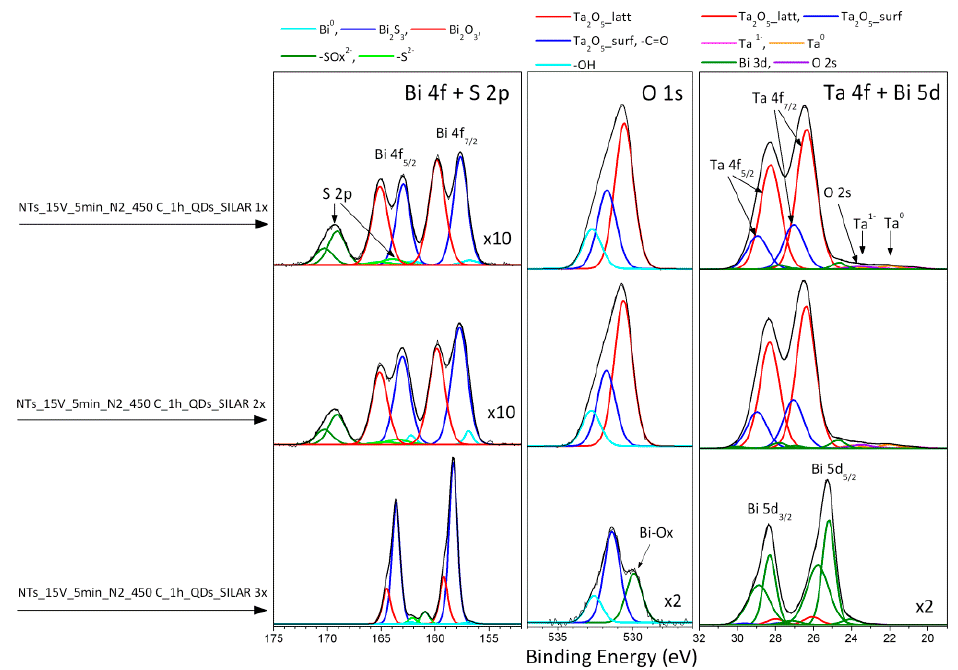
Figure 2. X-ray photoelectron spectroscopy (XPS) spectra of nanotube array (NT)-modified bismuth sulfide (Bi 2 S 3 ) quantum dots (QDs).